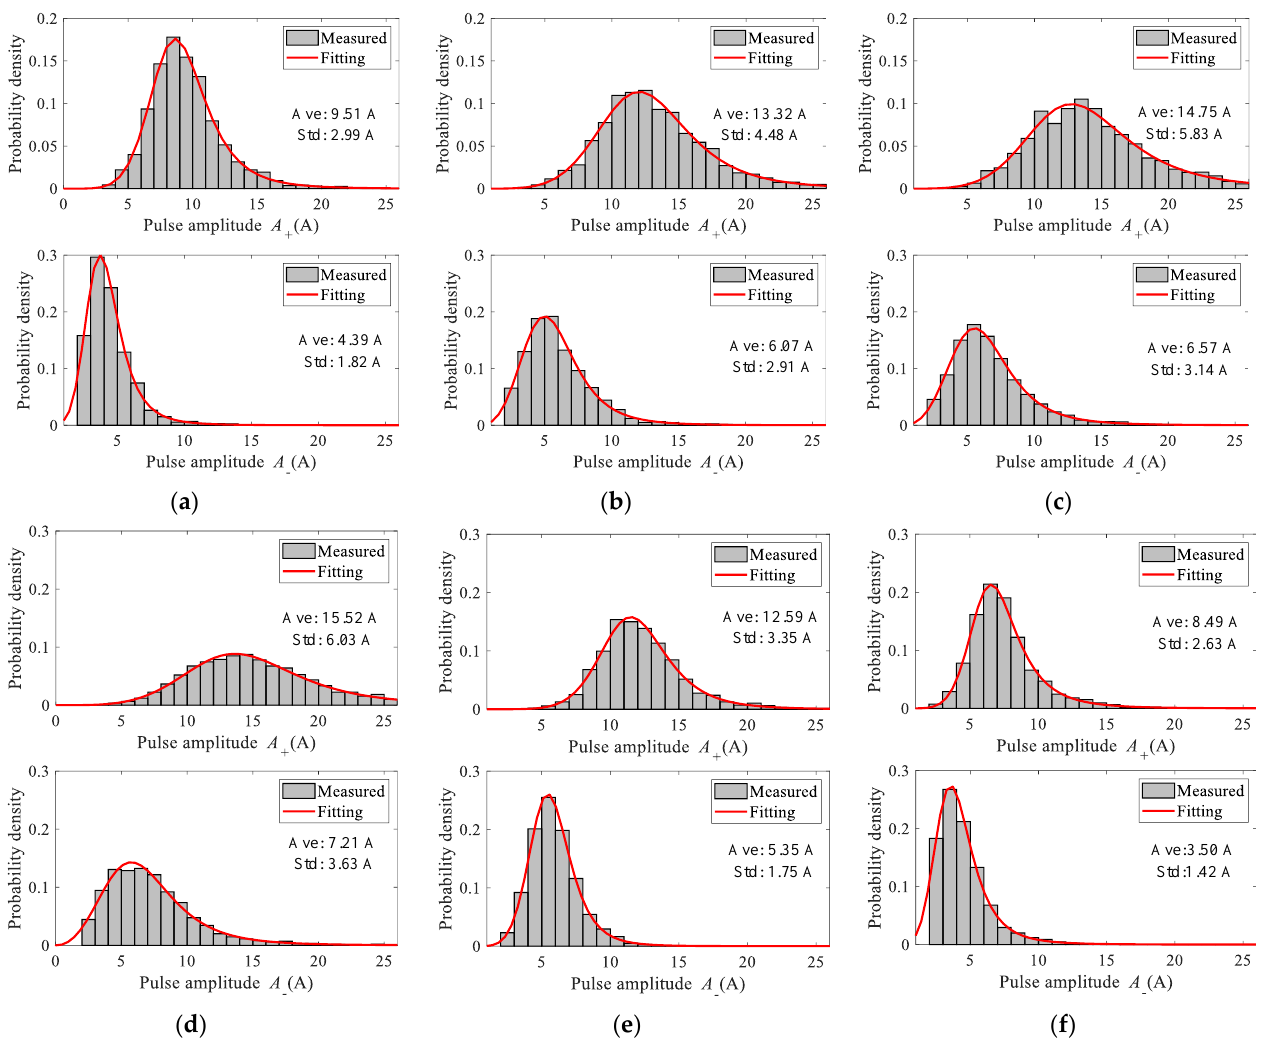
Figure 7. Statistical distributions of pulse amplitudes under different conditions: ( a ) U = 20 kV, d = 5 mm; ( b ) U = 25 kV, d = 5 mm; ( c ) U = 30 kV, d = 5 mm; ( d ) U = 35 kV, d = 5 mm; ( e ) U = 35 kV, d = 10 mm; ( f ) U = 35 kV, d = 15